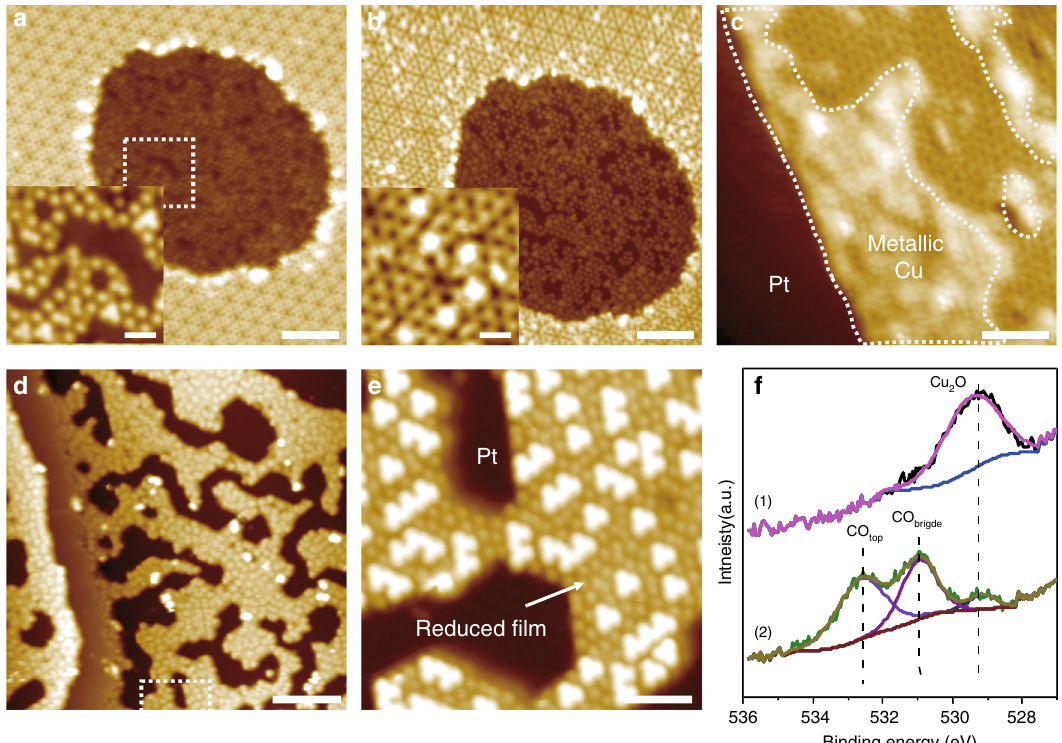
Fig. 2 The adsorption and reaction of CO on Cu 2 O/Pt(111). a , b In situ STM images of the Cu 2 O/Pt(111) surface during the exposure to CO at 78 K. The squared region in a is magni fi ed in inset, showing CO adsorption on a Pt(111) surface covered by (2 × 2)-O. Inset in b displays the adsorption sites of CO on Cu 2 O, which are centered at the holes of the Cu 2 O rings. c STM image of the partially reduced Cu 2 O/Pt(111) surface after the surface in b was annealed to 300 K. The reduction by CO started from both the step edge and the surface of Cu 2 O. The dotted curves indicate the regions of metallic Cu. d , e STM images of a Cu 2 O/Pt(111) surface after the exposure to 1 × 10 − 7 mbar CO for 5 min at 300 K. High-resolution STM image ( e ) from the marked area in d shows the reduction of Cu 2 O by CO led to the formation of triangular Cu 3 O x clusters, sitting on a metallic layer. f XPS O 1 s spectra of the Cu 2 O/Pt(111) surface before (1) and after (2) the exposure to 1.2 × 10 − 7 mbar CO for 5 min at 300 K. Lattice O of Cu 2 O with binding energy at 529.4 eV has been mostly consumed after CO exposure, accompanying the adsorption of CO on top sites (CO top ) and bridge sites (CO bridge ) of the exposed Pt surface. Scanning parameters: b V s = − 0.3 V, I = 0.2 nA; inset: V s = − 0.3 V, I = 0.5 nA; c V s = − 0.15 V, I = 1.2 nA; e V s = − 0.15 V, I = 0.5 nA. Scale bars: a , b 5 nm, inset 1 nm; c 3 nm; d 10 nm; e 2 nm.